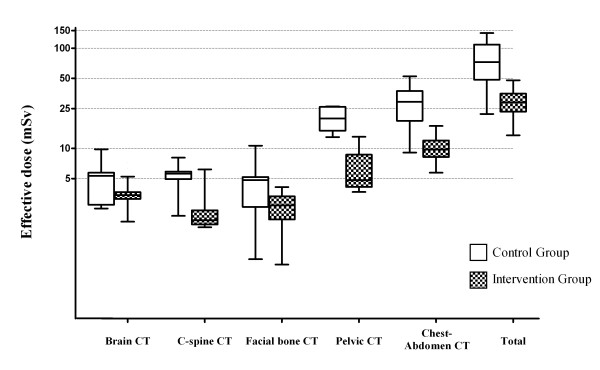
Box and whisker plot with median, 25th and 75th percentiles for the effective radiation dose from CT for the two groups. Control group included patients from May 2008 to April 2009, before use of the dose reduction strategy, and intervention group included patients from May 2009 to April 2010, after implementation of the dose reduction strategy.